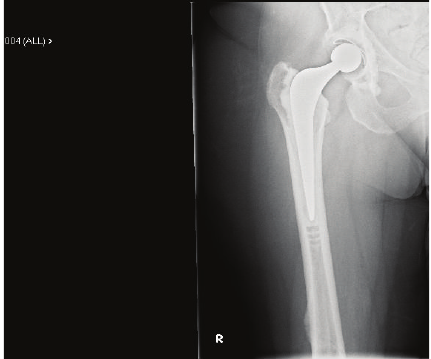
Figure 3: X-ray right femur showing callus